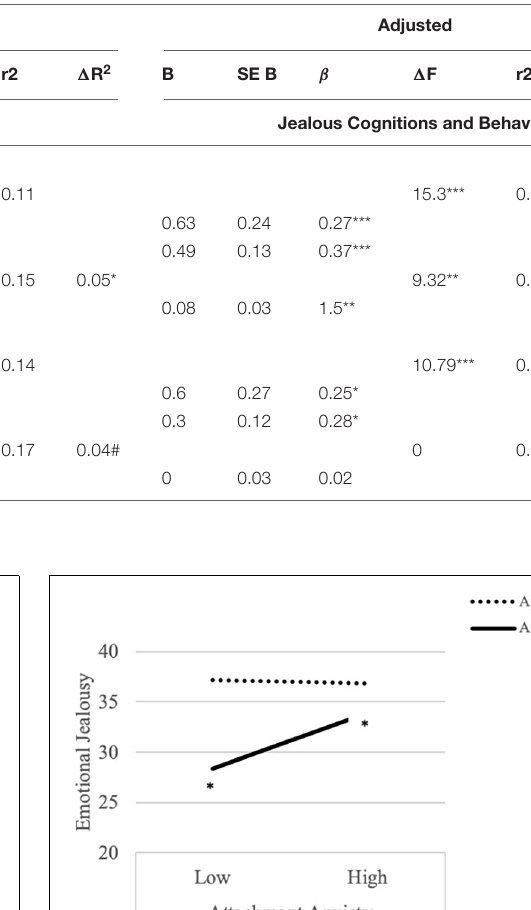
related to cognitive/behavioral jealousy, regardless of level